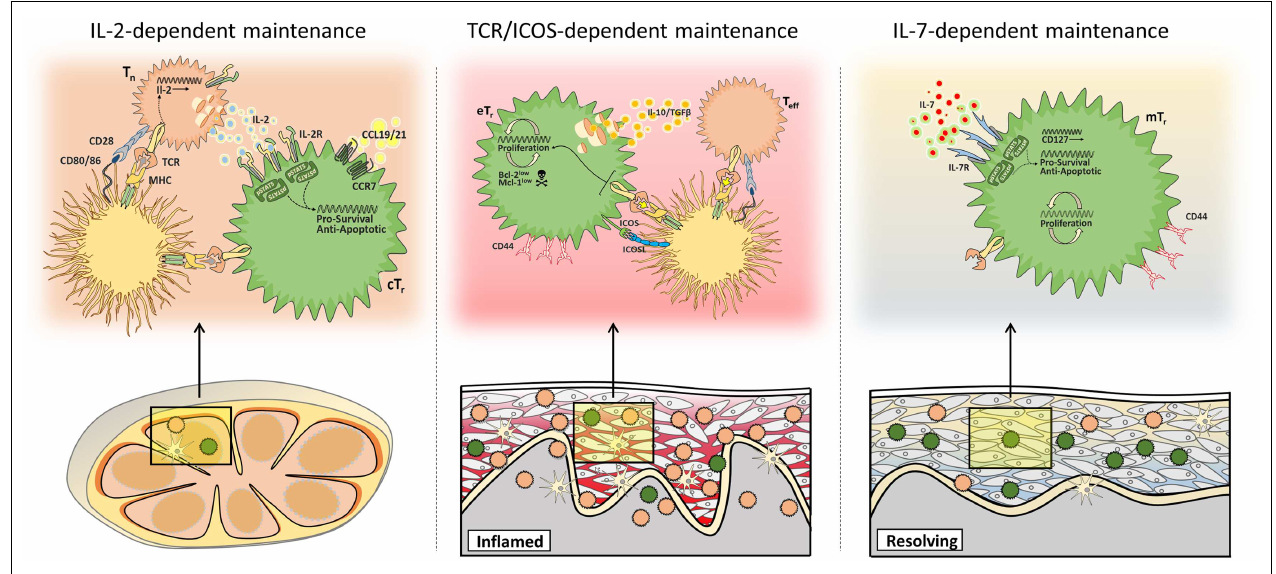
(left), whereas maintenance of effectorTreg cells (eT r ) in non-lymphoid tissues depends on continuedTCR/ICOS signals (middle), and memoryTreg cells (mT r ) in the skin are supported by IL-7/IL-7R-mediated survival signals